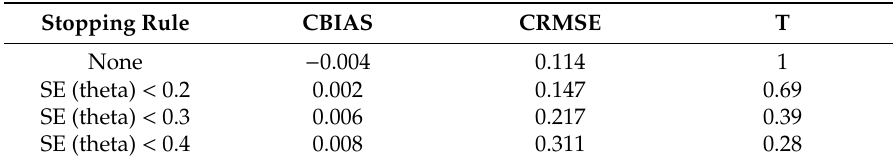
Table 2. CBIAS, CRMSE, and test overlap rate (T)